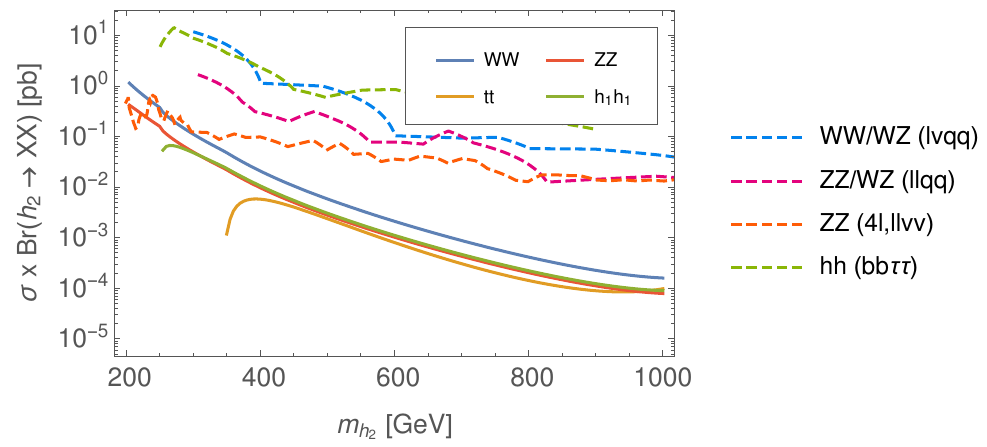
Figure 10 . (cid:27) (cid:2) Br( h 2 ! XX ) in di(cid:11)erent channels with corresponding collider limits. We have (cid:12)xed (cid:21) (cid:8) = 0 : 15 and s (cid:18) = 0 : 1.